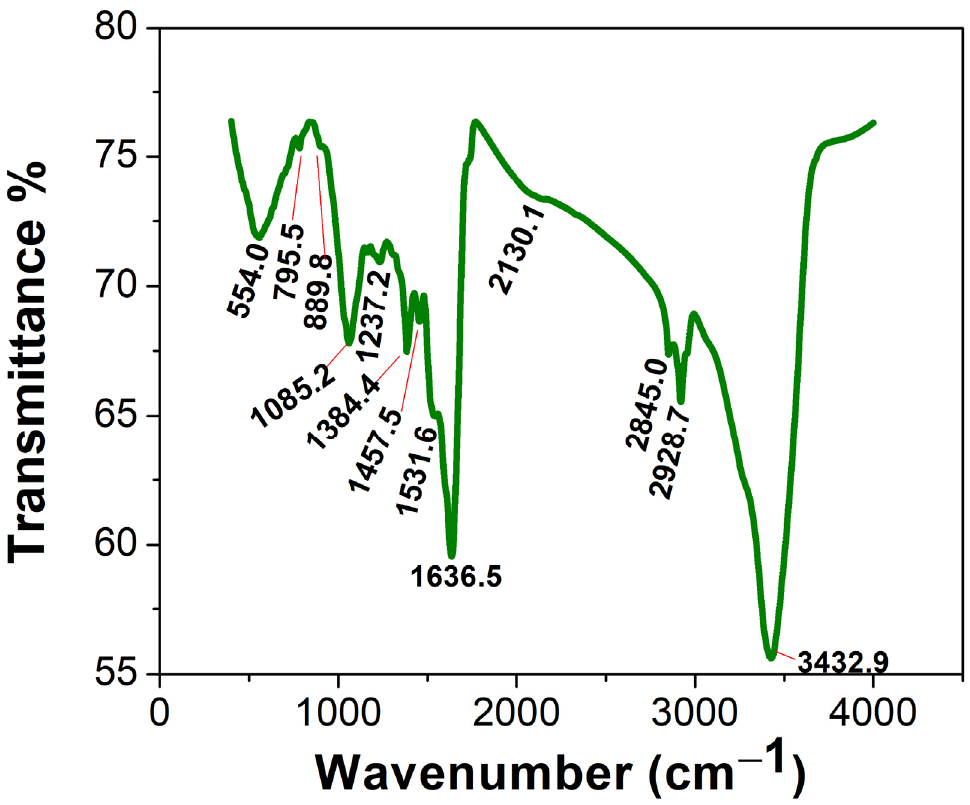
Figure 8. FTIR spectra of the Uv@Ag-NPs synthesised using the unicellular ulvophyte sp. MBIC10591.